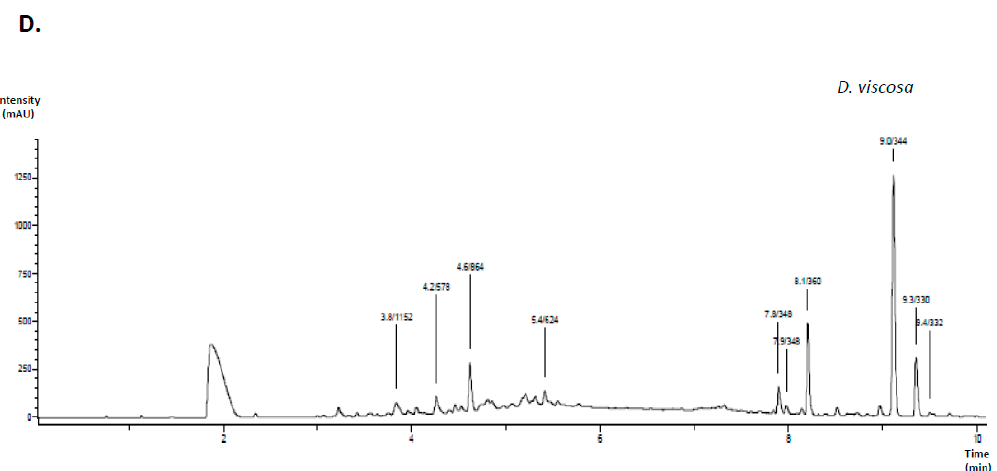
Figure 1. Identification of polyphenols from medicinal plant extracts. Polyphenols extracted from the medicinal plants Antirhea borbonica ( A ), Ayapana triplinervis ( B ), Terminalia bentzoe ( C ), and Dodonaea viscosa ( D ) were identified by Ultra-performance liquid chromatography coupled to electrospray ionization-tandem mass spectrometry analysis (UPLC-ESI-MS-MS) at 280 nm. Table 2. Compounds identified in polyphenol-rich extracts from medicinal plants. Medicinal Retention Molecular Plant Time (min) Weight (Da) Parent Ions Fragment Ions Identified